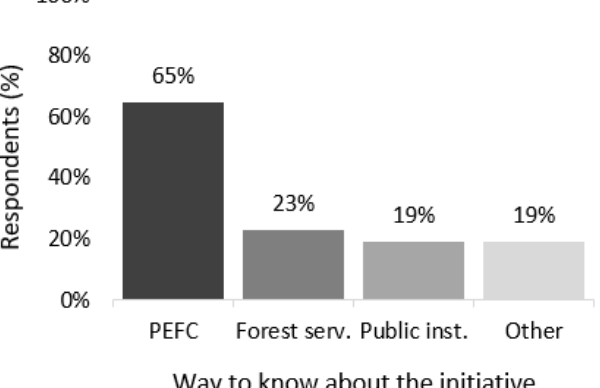
Figure 2. Percentage of respondents who already held a PEFC certification when they joined the initiative.